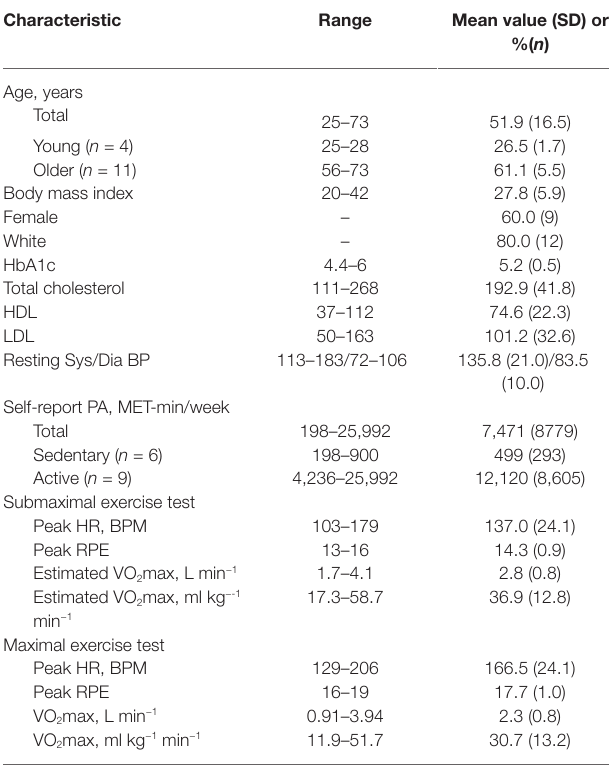
TABLE 1 | Background